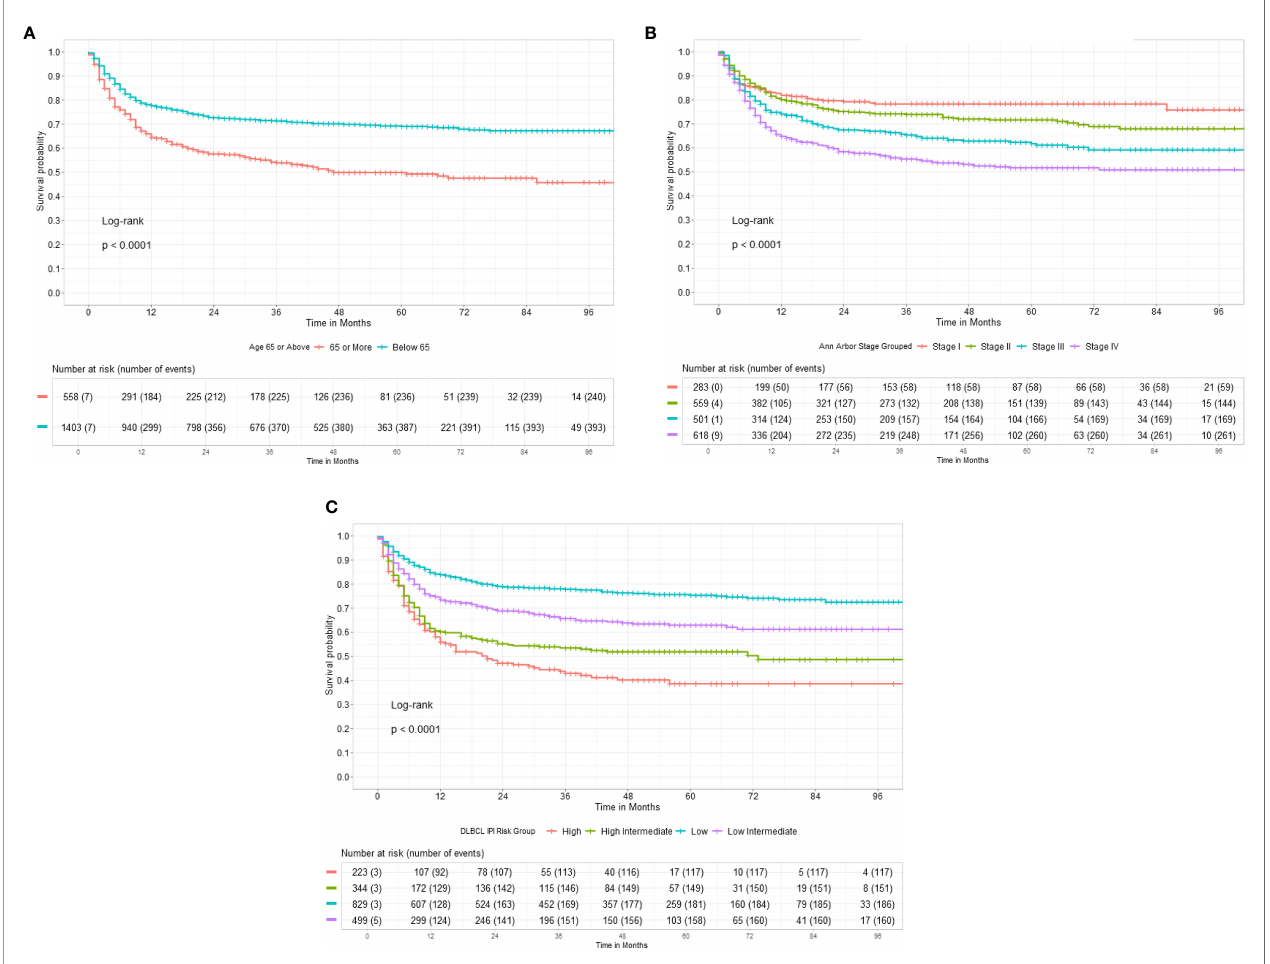
FIGURE 2 | (A) Three-year Event Free Survival according to Age of DLBCL patients at presentation. (B) Three-year Event Free Survival according to Stage of DLBCL at presentation. (C) Three-year Event Free Survival according to International Prognostic Index risk group at